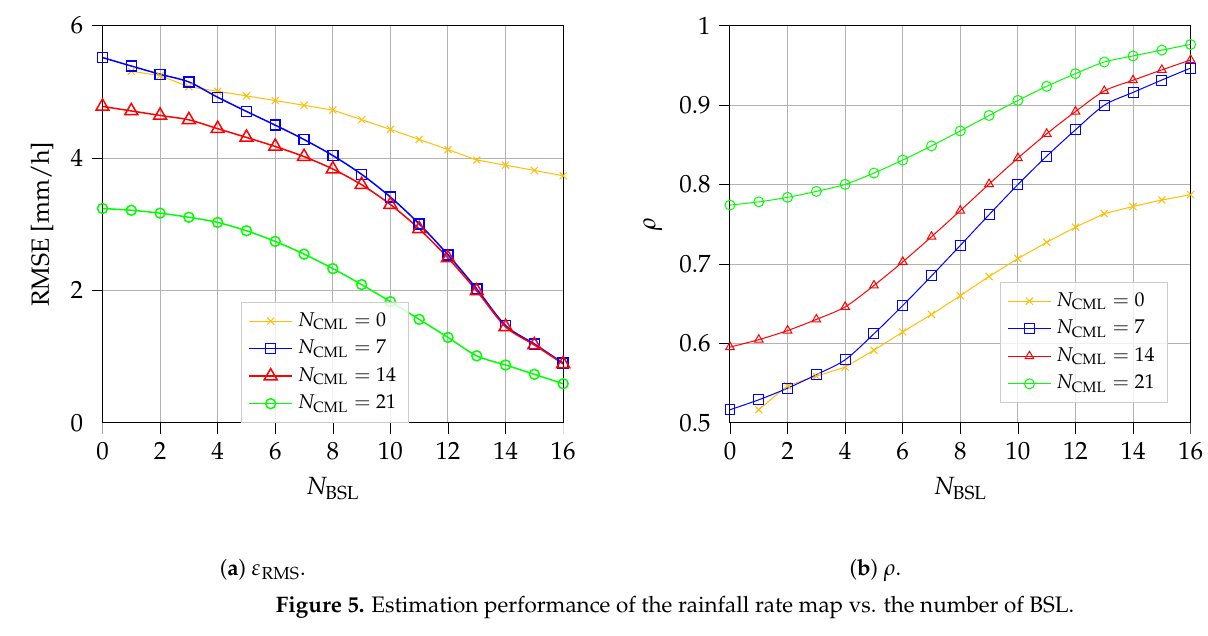
Figure 5. Estimation performance of the rainfall rate map vs. the number of BSL.